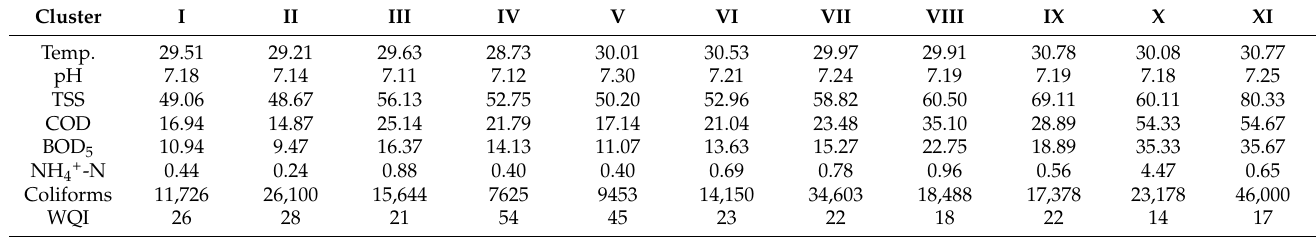
Figure 4. The spatial distribution of similar water quality clusters. Table 3. Mean values of water quality parameters obtained from cluster